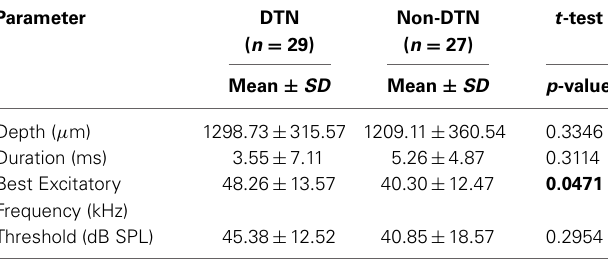
Table 1 | Summary statistics of general response properties of DTN and